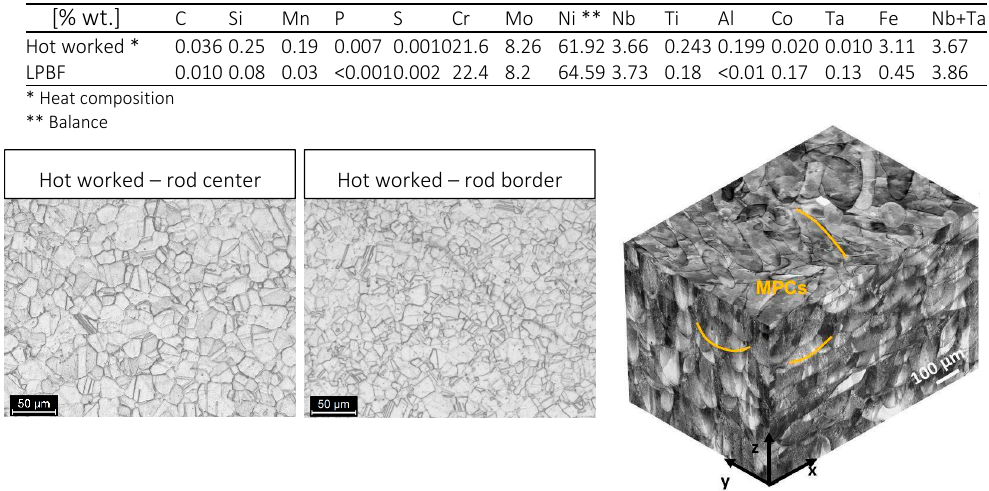
Figure 1. Chemical composition and 3D optical image composite of as-built IN625 sample showing the melt pool contours (MPCs) along the building direction (z-axis) and perpendicular to the building direction (x-y) plane; mixed acids reagent was used.